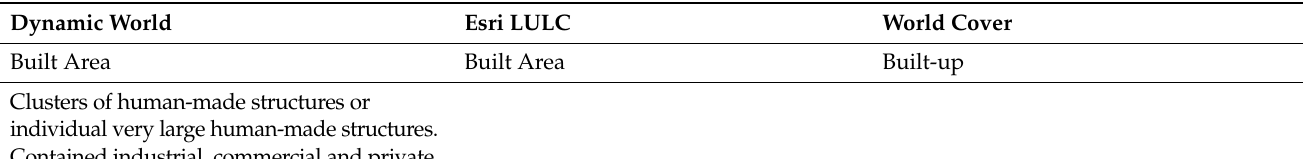
Table 1. Classification typology cross-walk between the three global 10 m LULC maps included in this